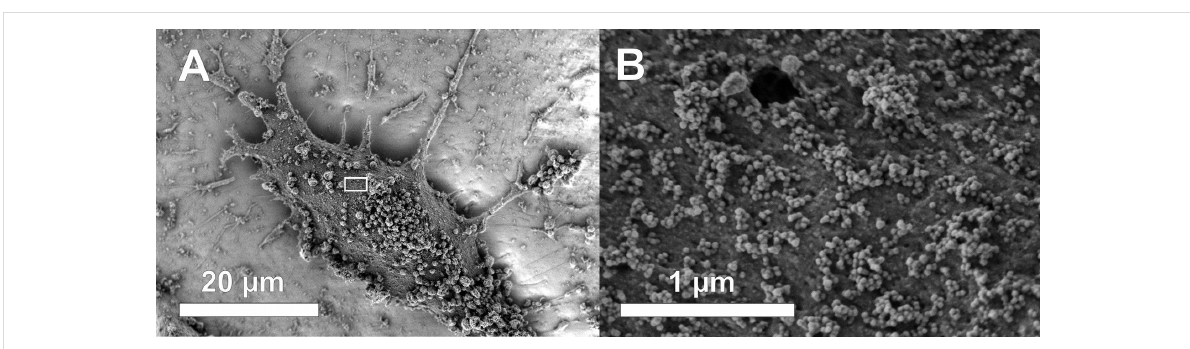
Figure 3: SEM micrograph of a HeLa cell exposed to 100 µg·mL − 1 of SiNP-22 for 15 min before CPD preparation. Besides the large agglomerates the surface of the cell is covered with many individual, non-aggregated NPs (B, close-up of the area indicated in A).